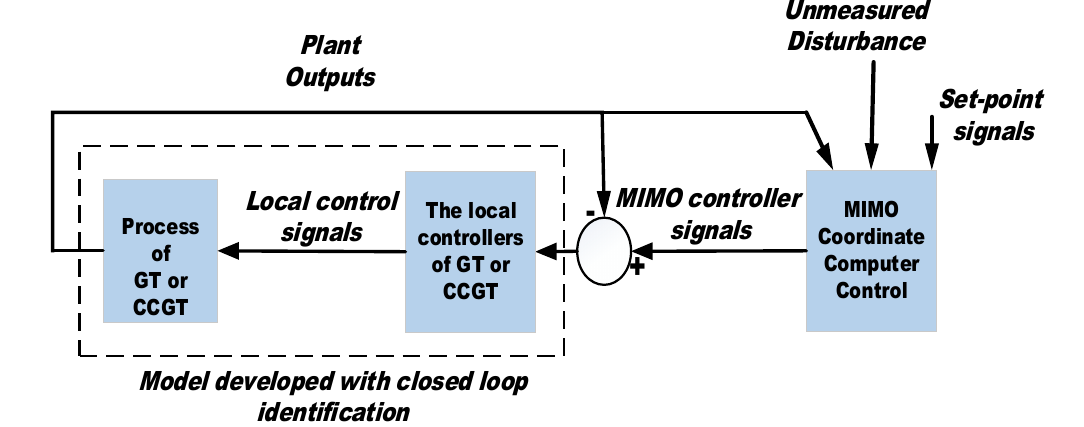
Figure 6. Supervisory control with reference adjustment. Energies 2020 , 13 , x FOR PEER REVIEW